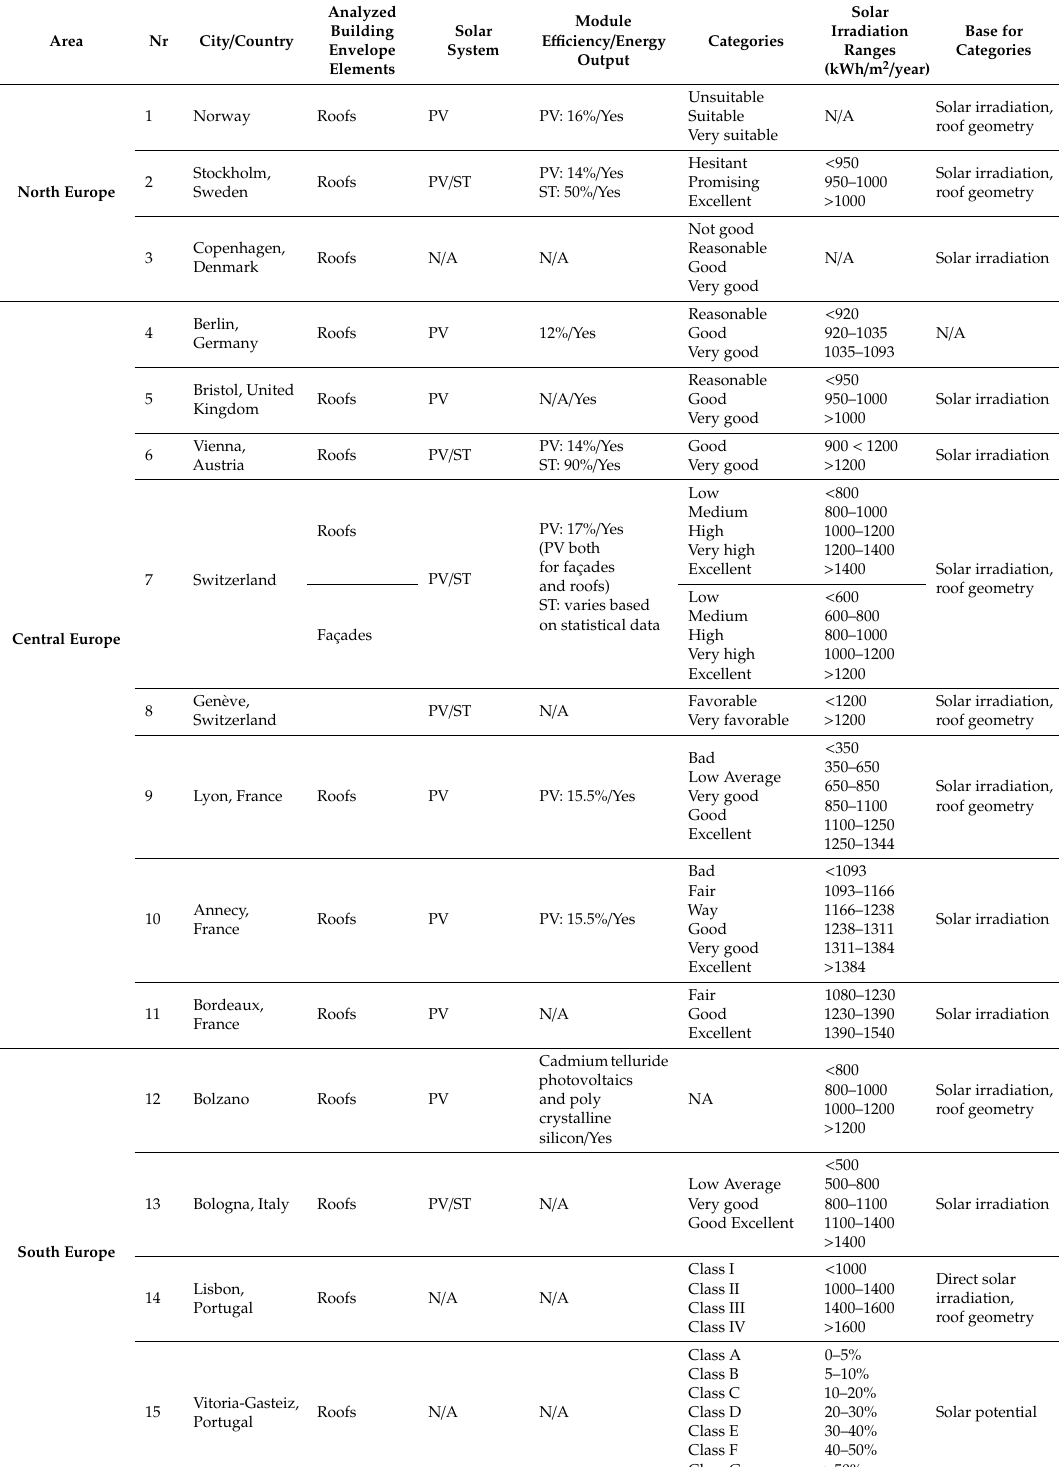
Table 1. List of ten selected existing solar maps in Europe that have been recently developed.